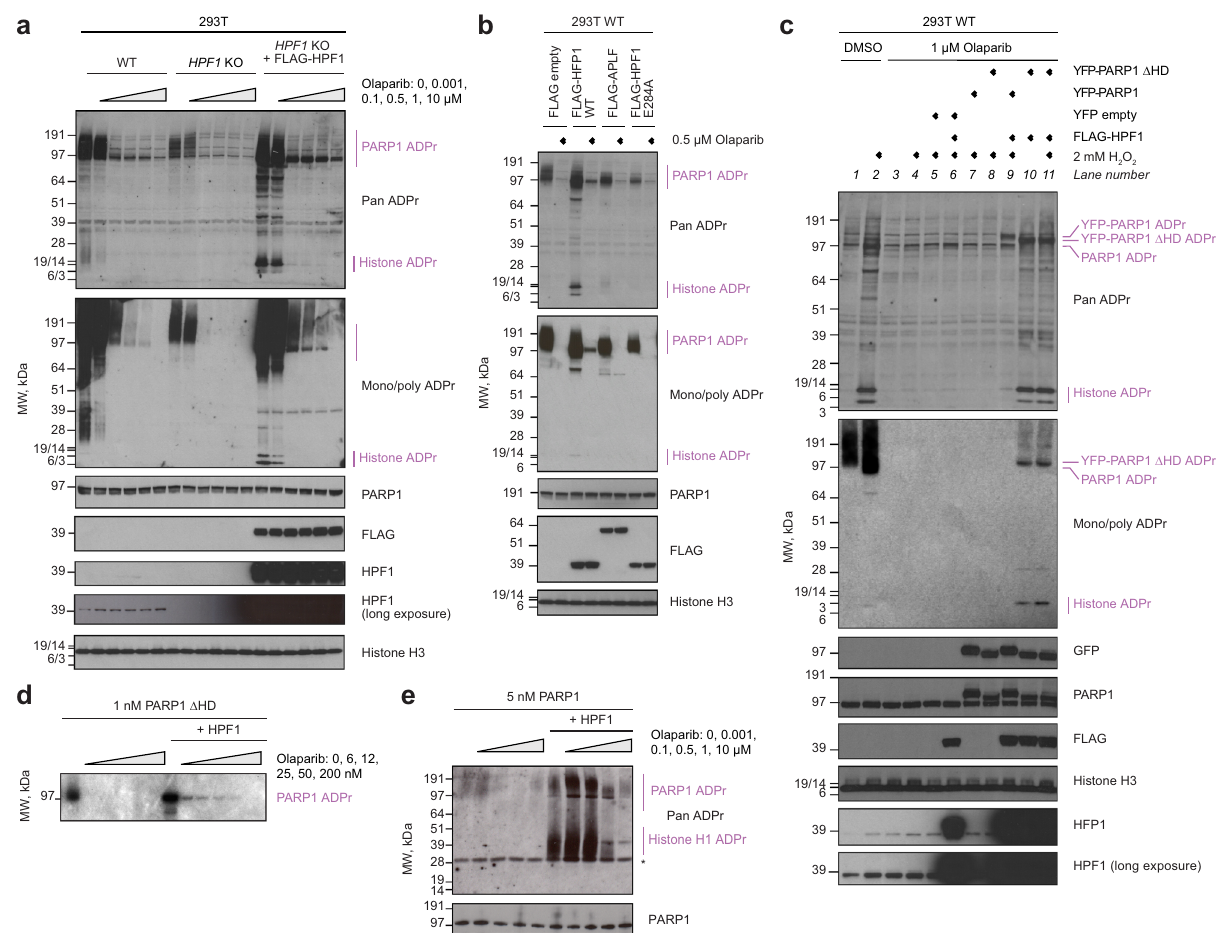
Fig. 2 Serine ADPr persists at high doses of PARP1/PARP2 inhibitor. a Cellular ADPr levels detected throughout increasing molarities of Olaparib depend on HPF1 status. b Overexpression of FLAG-HPF1 WT but not catalytic mutant E284A leads to ADPr that persists despite Olaparib treatment. c High ADPr levels achieved by YFP-PARP1 Δ HD overexpression despite Olaparib treatment depend on simultaneous FLAG-HPF1 overexpression. ADPr levels are also increased above basal levels for this Olaparib concentration by DNA damage (H 2 O 2 ), FLAG-HPF1 overexpression, or simultaneous YFP-PARP1 and FLAG-HPF1 overexpression. A similar experiment in PARP1 KO cells is shown in Supplementary Fig. 3b. d In vitro radioactive ADPr assay shows ADPr can be detected at higher Olaparib molarities when HPF1 is present in the reaction. e In vitro ADPr assay with higher NAD + concentration than in ( d ) and histone H1 as a substrate. Both PARP1 and histone H1 ADPr can be detected at relatively high Olaparib molarities when HPF1 is present. Asterisk indicates non-speci fi c recognition of unmodi fi ed histone H1 by the Pan ADPr reagent. In the Pan ADPr blots in ( a ) and ( c ), the weak bands recurrent across all conditions represent a background against which speci fi c signal should be interpreted. a – e The experiments were performed independently at least 2 times with